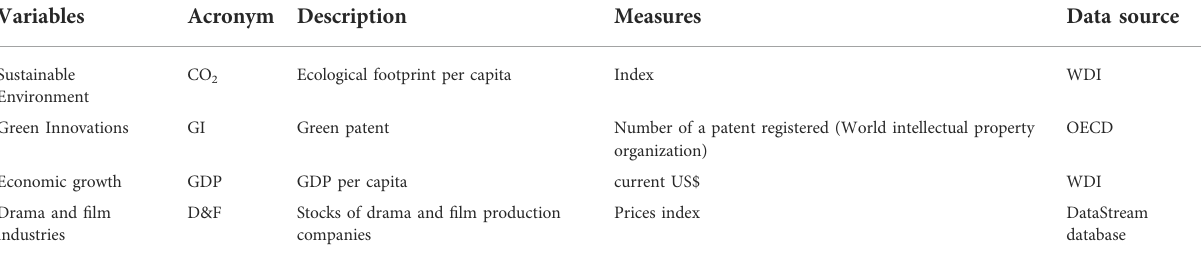
TABLE 2 Synopsis of Data description and variable